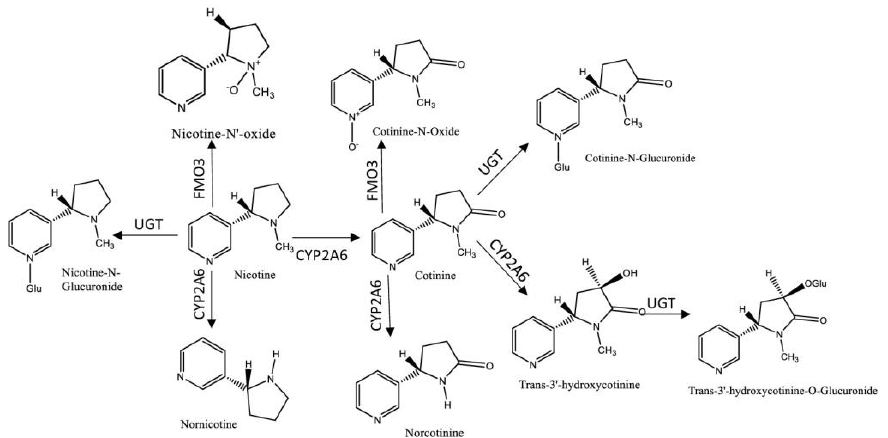
Figure 1. Metabolic profile of nicotine. Legend: (UGT-UPD-glucuronosyltransferases; FMO3-Flavin-containing monooxigenase 3; CYP2A6- cytochrome P450 2A6).